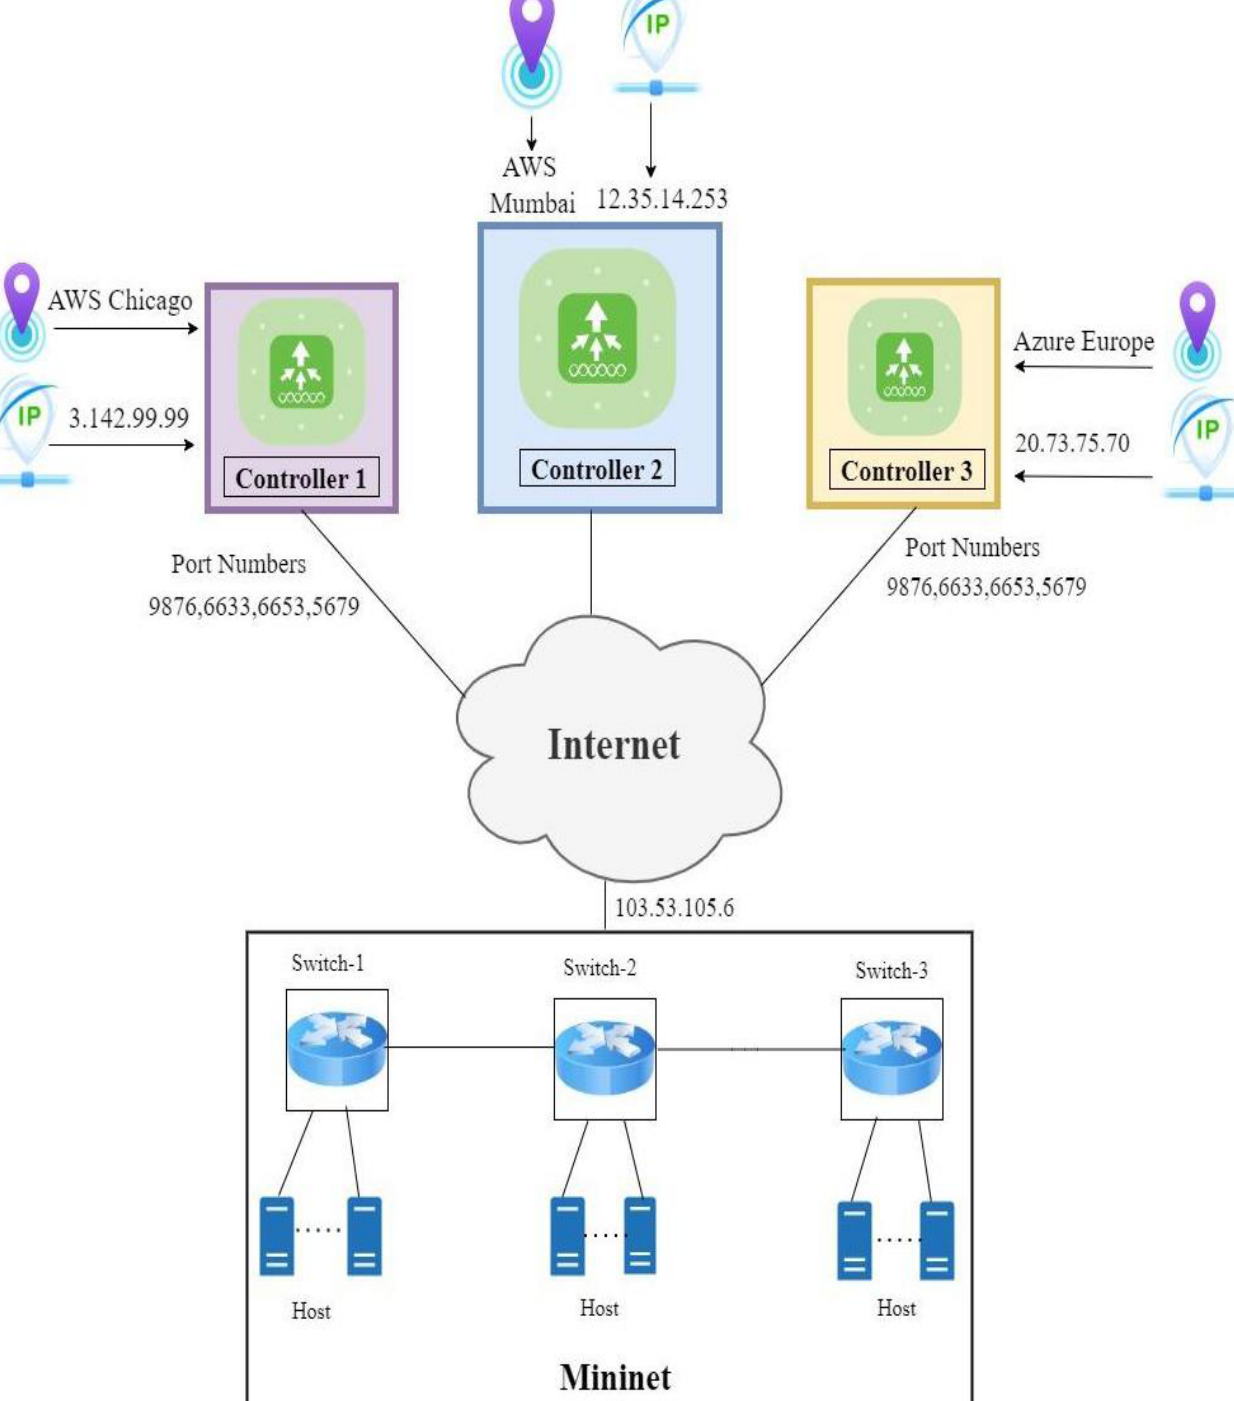
Figure 1. Experimental set.